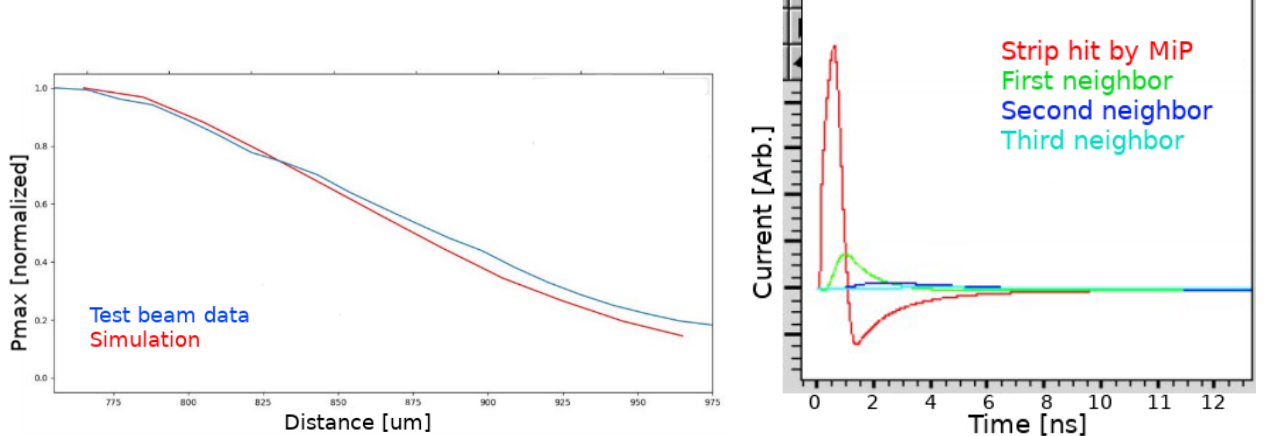
Figure 5. ( Left ) Pulse maximum as a function of position for a single strip 80 µ m wide in a sensor with a pitch 200 µ m, left edge of the plot is the center of the strip. Curves are for data (FNAL testbeam) in blue and TCAD Silvaco simulation in red. ( Right ) AC-LGAD strip simulated waveform with TCAD Silvaco, charge deposition is the strip with the red waveform, green is first neighbor, blue is second